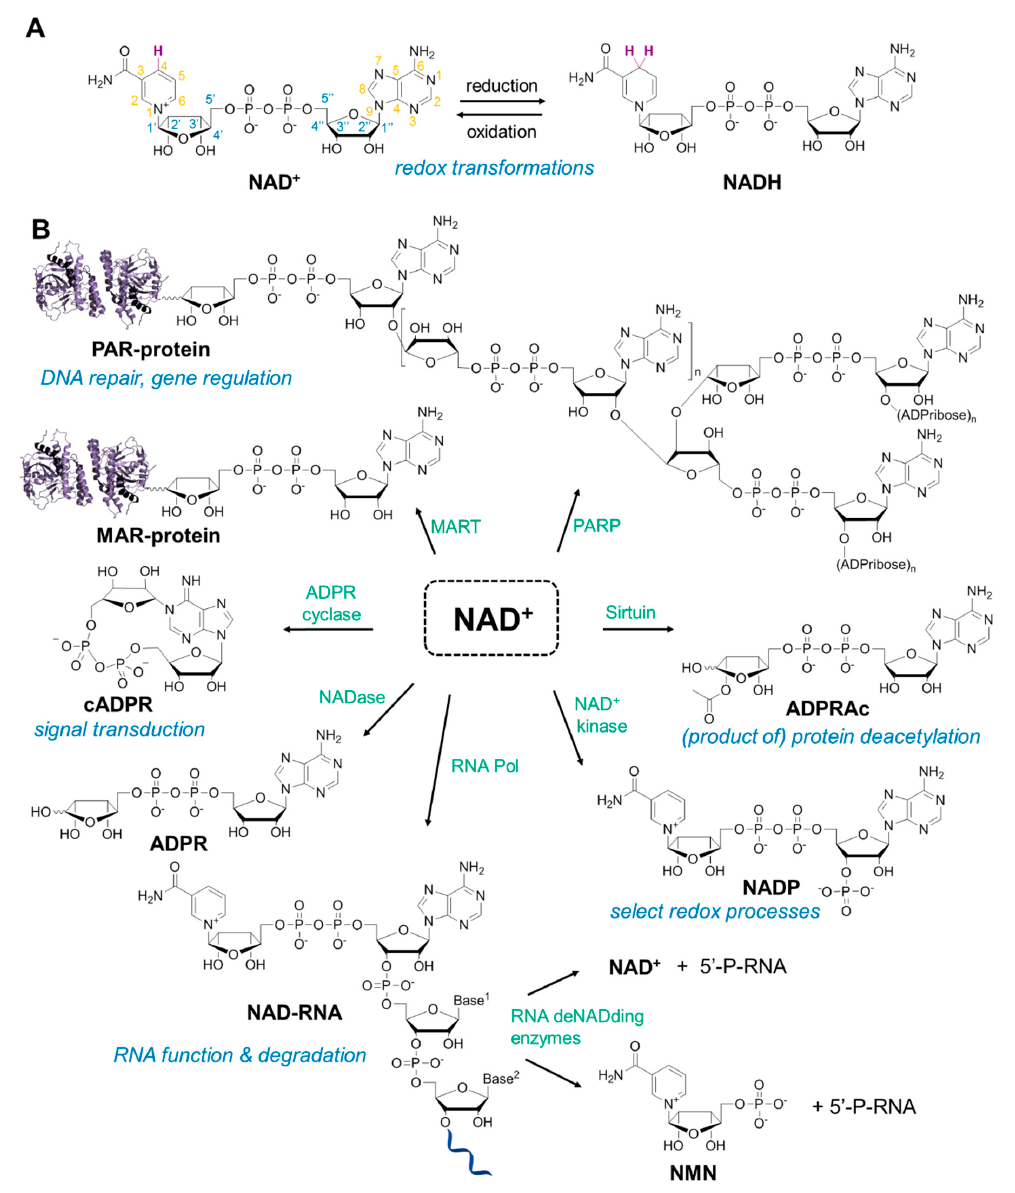
Figure 1. Biological roles of NAD in eukaryotes. ( A ) The NAD + / NADH pair commonly involved in cellular redox transformations; atom numbering is shown on NAD + ; ( B ) Select enzymatic reactions consuming NAD + leading to miscellaneous NAD derivatives and metabolites (labelled in bold). The enzymes catalyzing NAD-dependent reactions are labelled in green and the biological processes involving or affected by their products are marked in blue.